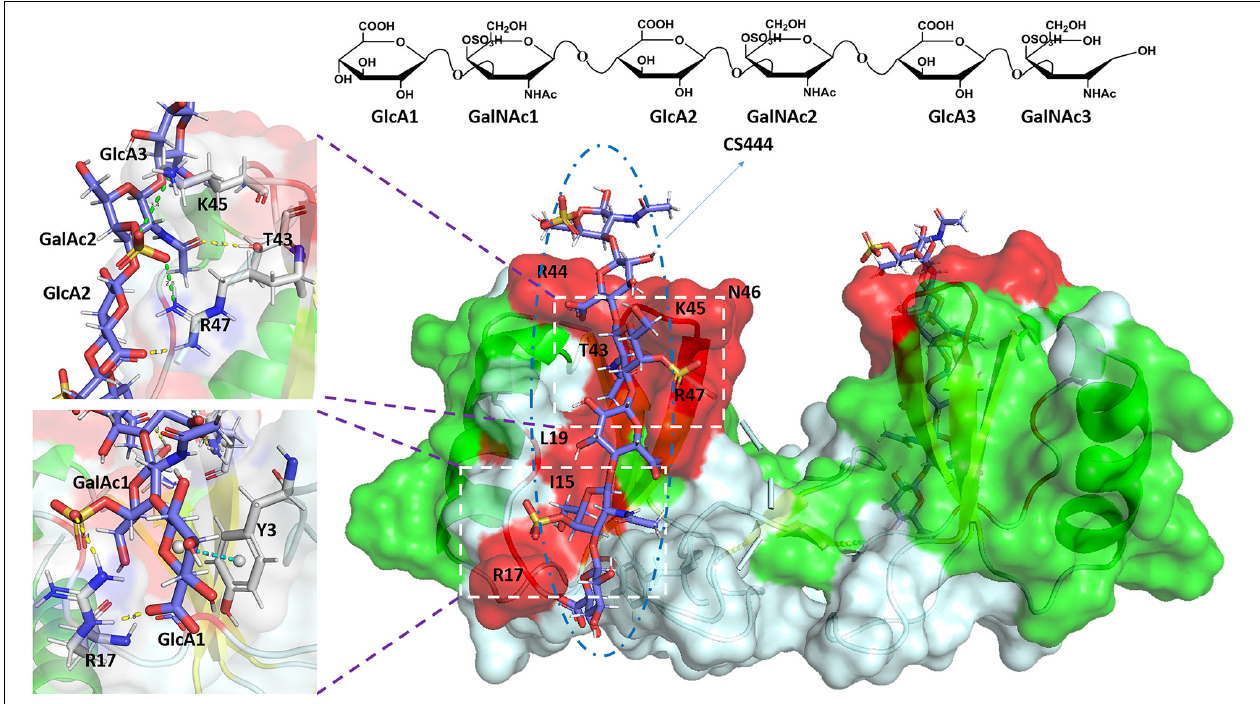
FIGURE 2 | Complex of CCL5 dimer and CS444. In the cartoon and surface hybrid model, the CS combined area is displayed in red. In the enlarged image, other non-covalent interactions are shown. The yellow dashed line represents hydrogen bonds, the green dashed line represents ionic bonds, and the blue dashed line represents ring-stacking interactions. The figure was prepared using the PDB file originally reported in the reference (Deshauer et al., 2015).